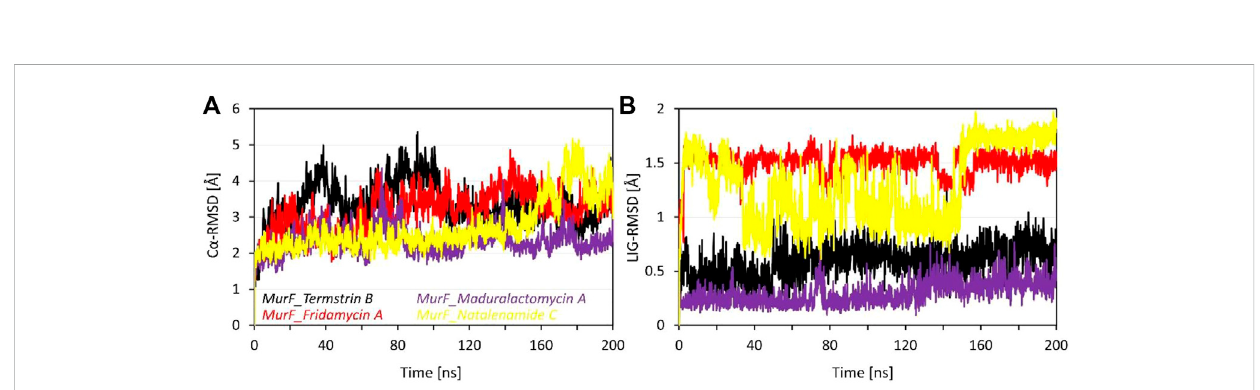
FIGURE 3 Root meanssquaredeviation analysis of theMurFproteinof A.baumannii after 200 ns of molecular dynamics simulations. Where (A) represents the lineRMSDgraphforC α atomsofMurFproteinwhile (B) representstheRMSDvaluesofeachcompoundwithrespecttoitsinitialpositionwithintheactive site. The line graph is enriched with colour-coded legends for each